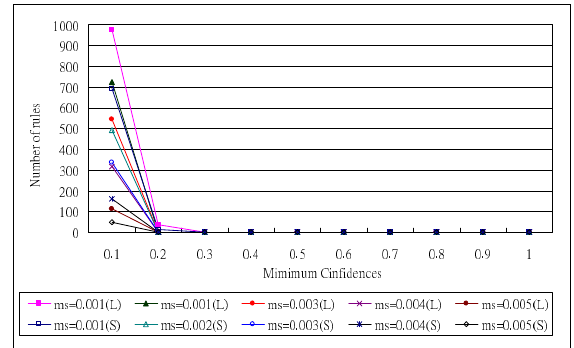
Fig. 8. The number of rules derived by the proposed approach for the uniform dataset